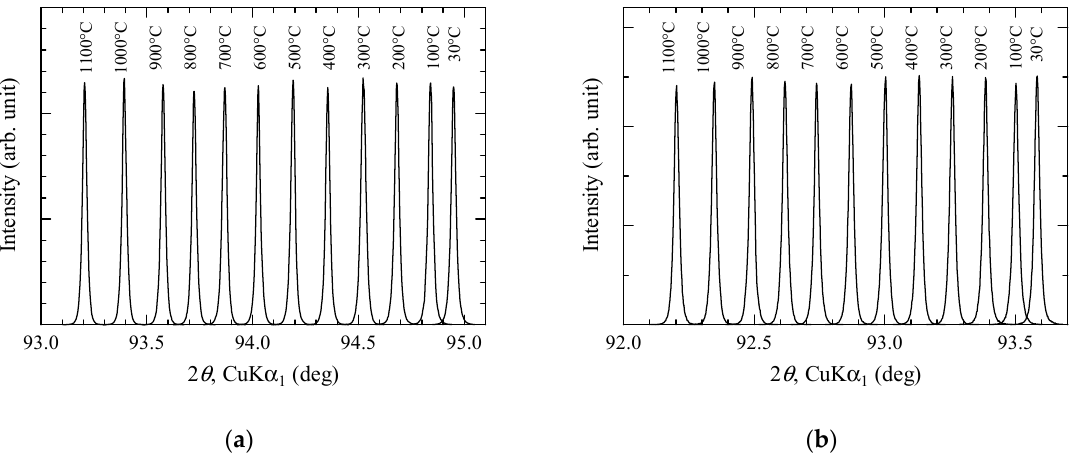
Figure 2. High-resolution 2 θ — ω scan results with various sample temperatures measured around ( a ) 00 , 024 and ( b ) 11-218 diffraction peaks of SCAM single crystal.